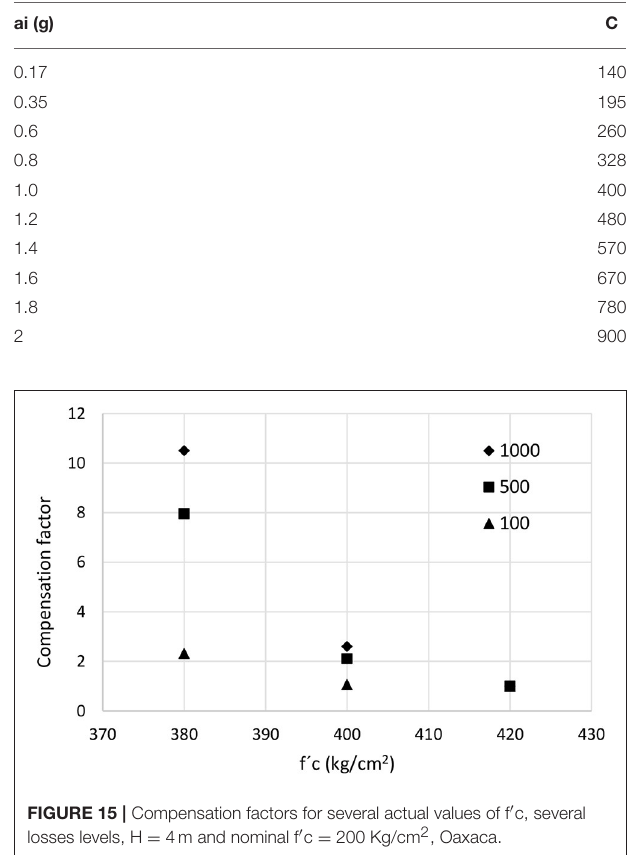
TABLE 7 | Initial costs for scenario seismic ground accelerations (million USD) for Oaxaca, H = 4 m and f’c = 420 kg/cm 2 .